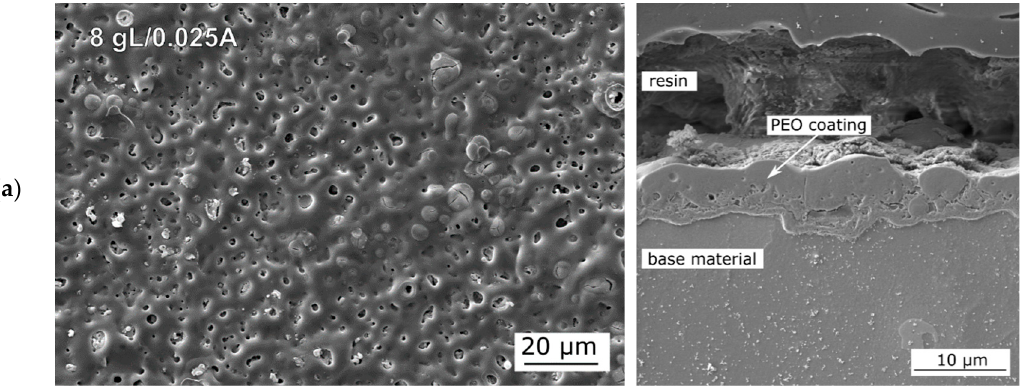
Table 2. Steady state values of voltage recorded during the PEO process.